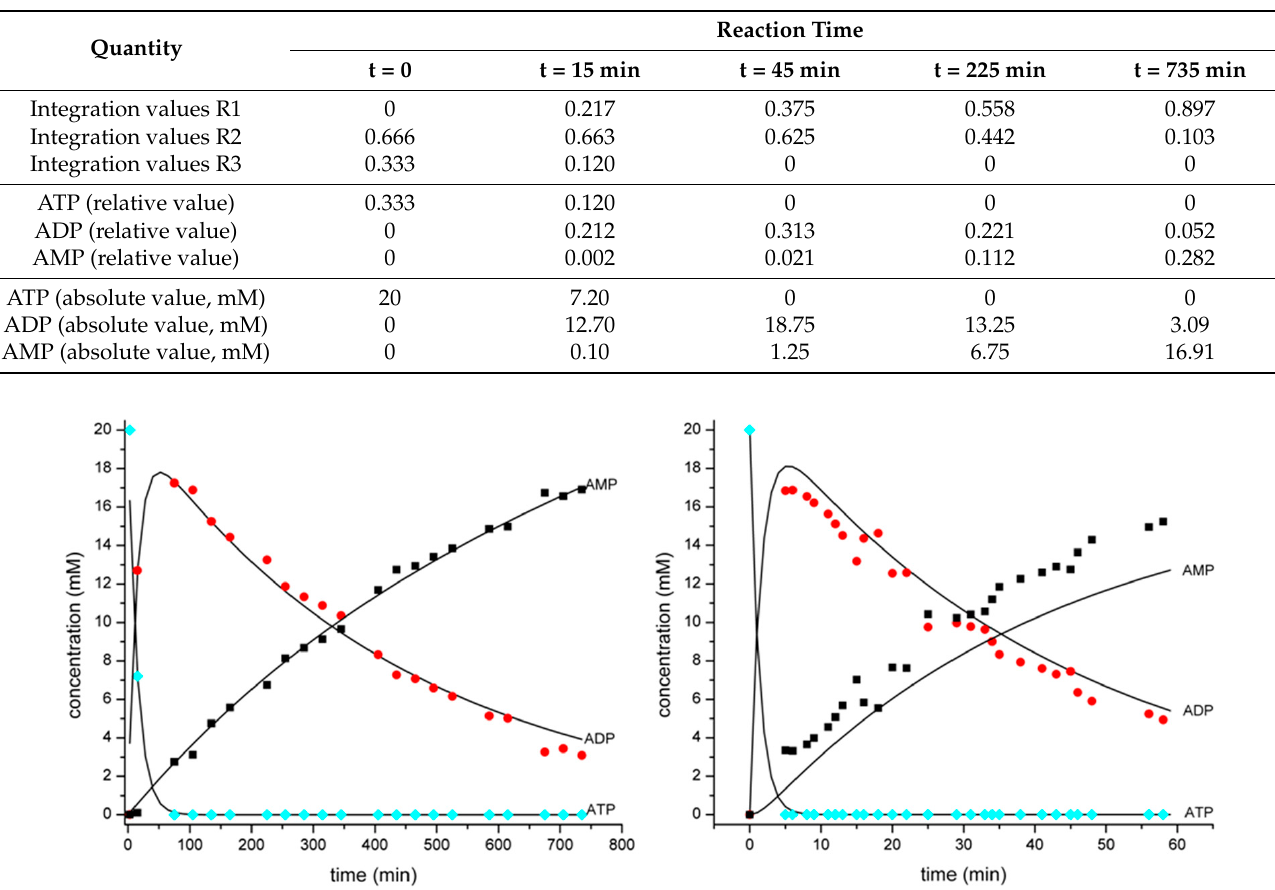
Figure 3. Concentration of ATP, ADP and AMP (dots) in solution as a function of time for a reaction mixture containing ATP (20 mM) and Na 3 VO 4 (initial concentration = 200 mM) in the presence of NaCl (600 mM) at pH 2 and 25 °C ( left ) or 50 °C ( right ). The concentration profiles were fitted to Equations (5)–(7) (lines, R 2 25 °C—ATP: 0.9616, ADP: 0.9739, AMP: 0.9951; R 2 50 °C—ATP: 0.9889, ADP: 0.8459, AMP: 0.8786). Table 3. Rate constants (s − 1 ) for the hydrolysis of ATP with polyoxovanadates at pH = 2–7 and T = 25 °C, 37 °C and 50 °C 1 .